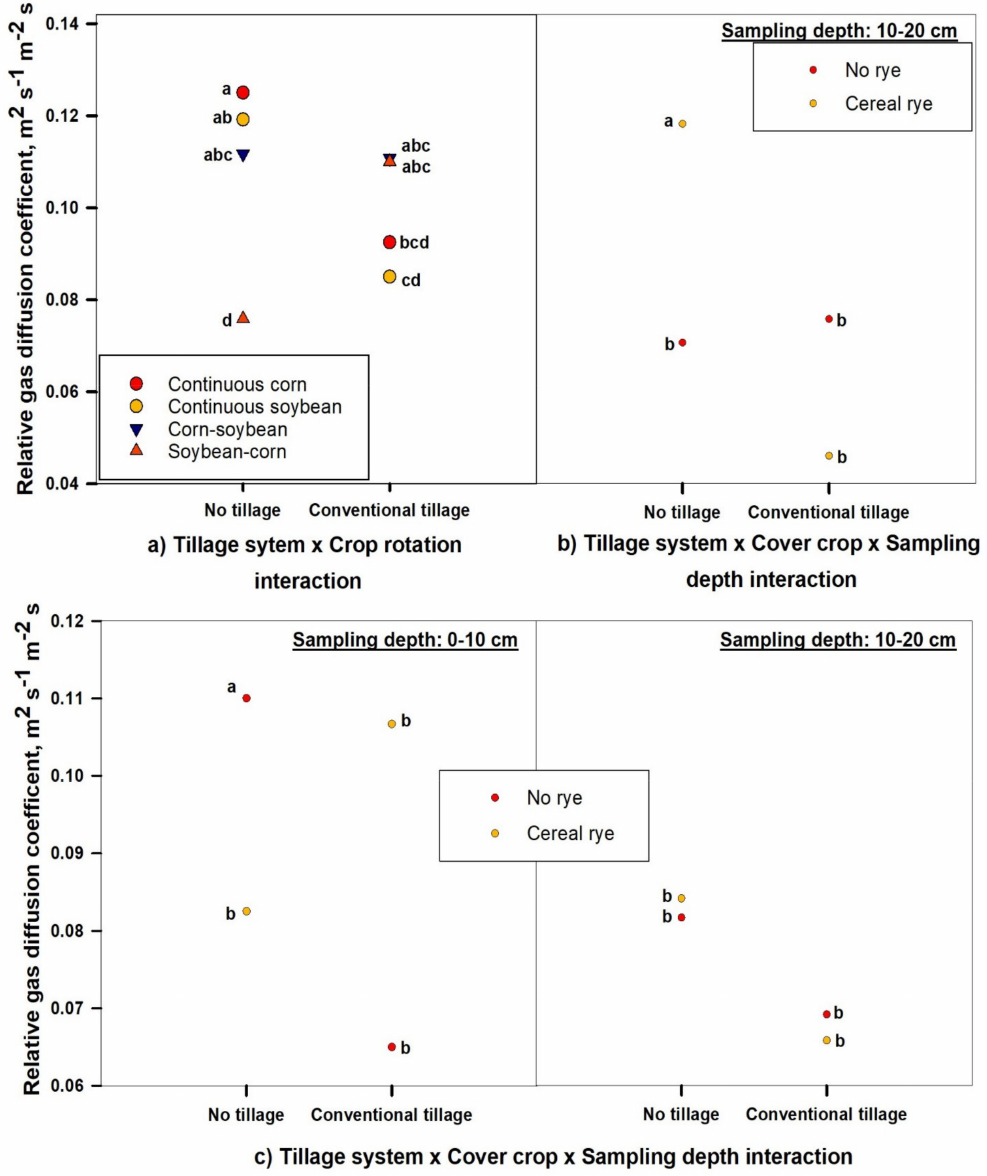
Figure 3. Interaction effect of different treatments on means of relative gas diffusion coefficient: ( a ) tillage system × crop rotation in 2011, ( b ) tillage system × cover crop × sampling depth at 10–20 cm in 2012 (note: tillage system × cover crop × sampling depth at 0–10 cm in 2012 was not significant at p < 0.05) and ( c ) tillage system × cover crop × sampling depth in 2013. Means followed by the same lowercase letter are not significantly